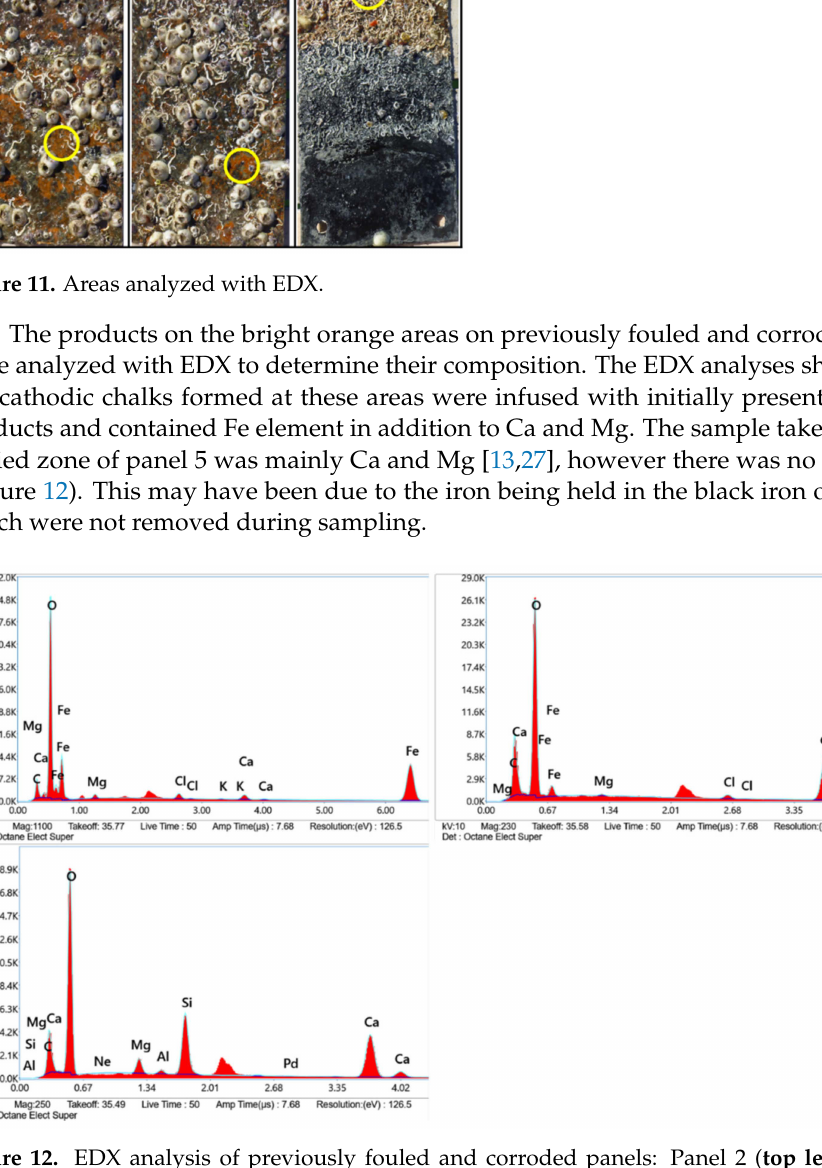
Figure 12. EDX analysis of previously fouled and corroded panels: Panel 2 ( top left ), Panel 3 ( top right ), and Panel 5 ( bottom left